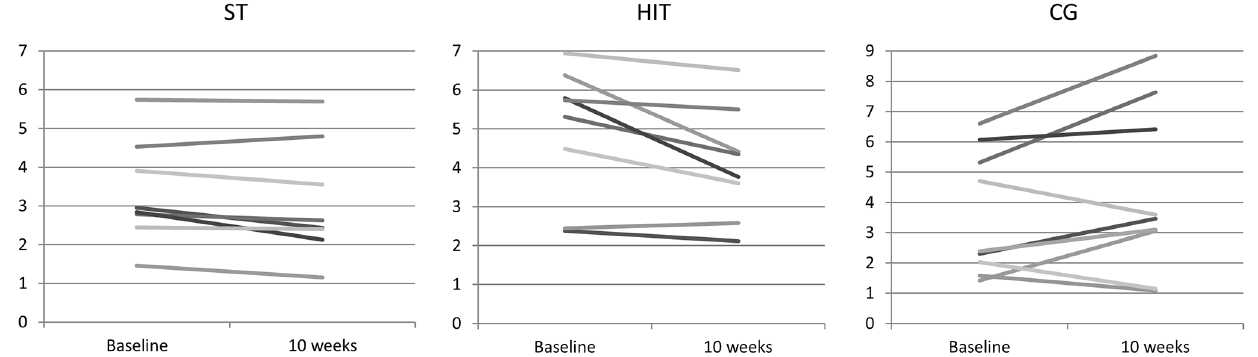
Fig 4. Individual changes in HOMA IR from baseline to